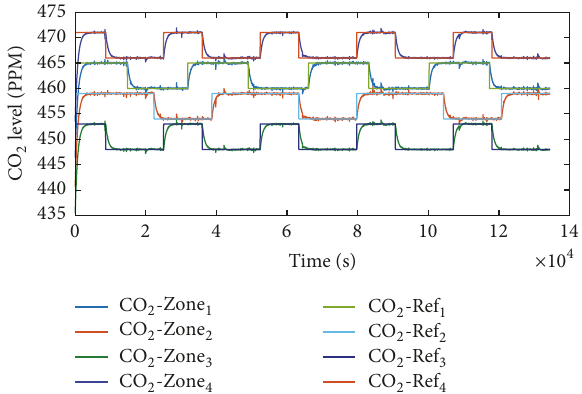
Figure 17: Outputs response of the CO 2 level for the zones CO 2 - Zones with steps references CO 2 -Refs.